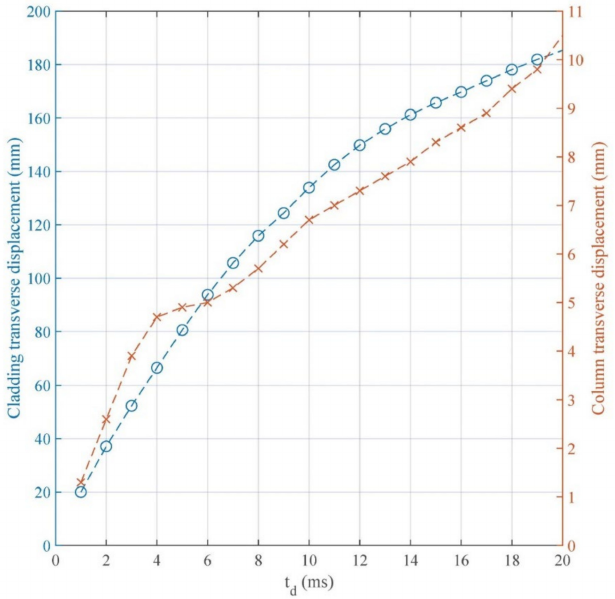
Figure 14. Numerical model transverse displacement of the case study cladding and column at constantly increasing positive phase duration (pressure